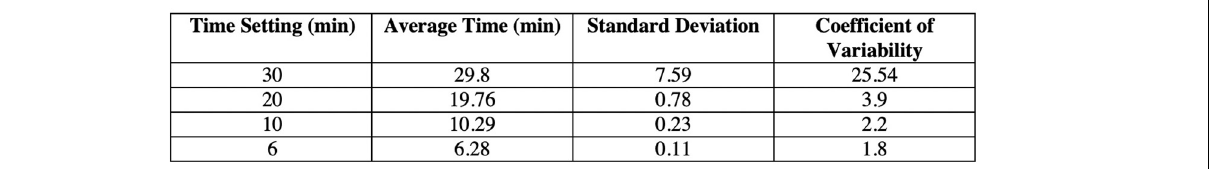
FIGURE 2 | Table that holds the results of 30, 20, 10, and 6 min stoppers showing the performance of each.